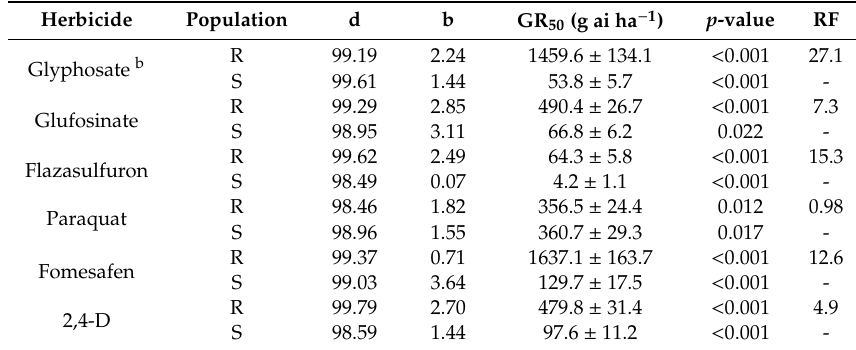
Table 3. Parameters for estimating the log-logistic model a of the growth reduction in response to herbicide concentration for the R and S P. hysterophorus populations treated with the main herbicides used in banana crops in the Dominican Republic.